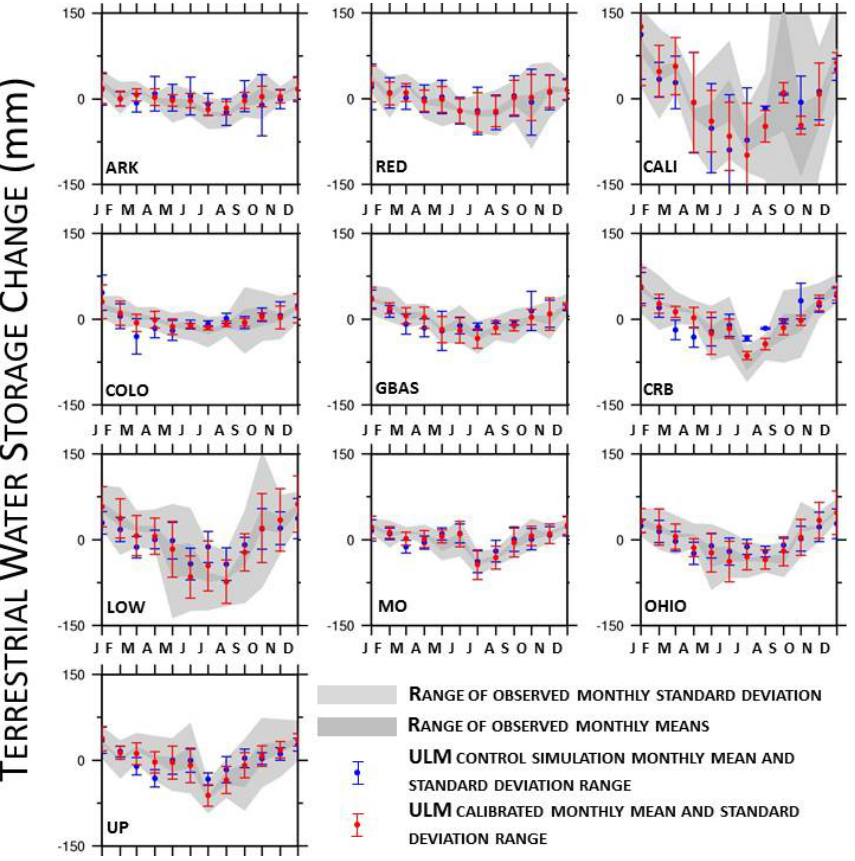
Fig. 8. Mean monthly TWSC (mm) for the major river basins for the period 2002–2010 including the control and calibrated model simula- tions; the range of variability for each case is shown